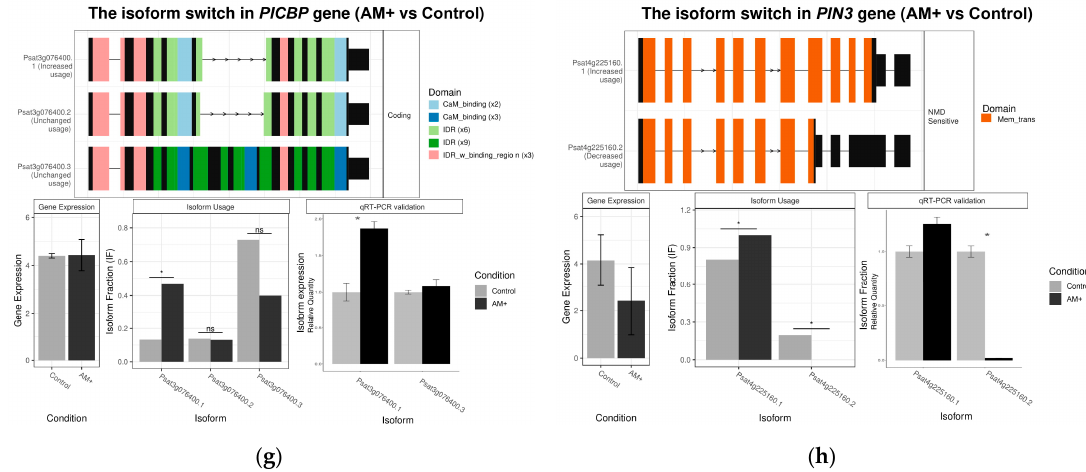
Figure 4. Structural and expression analysis of genes for which differential AS has biological